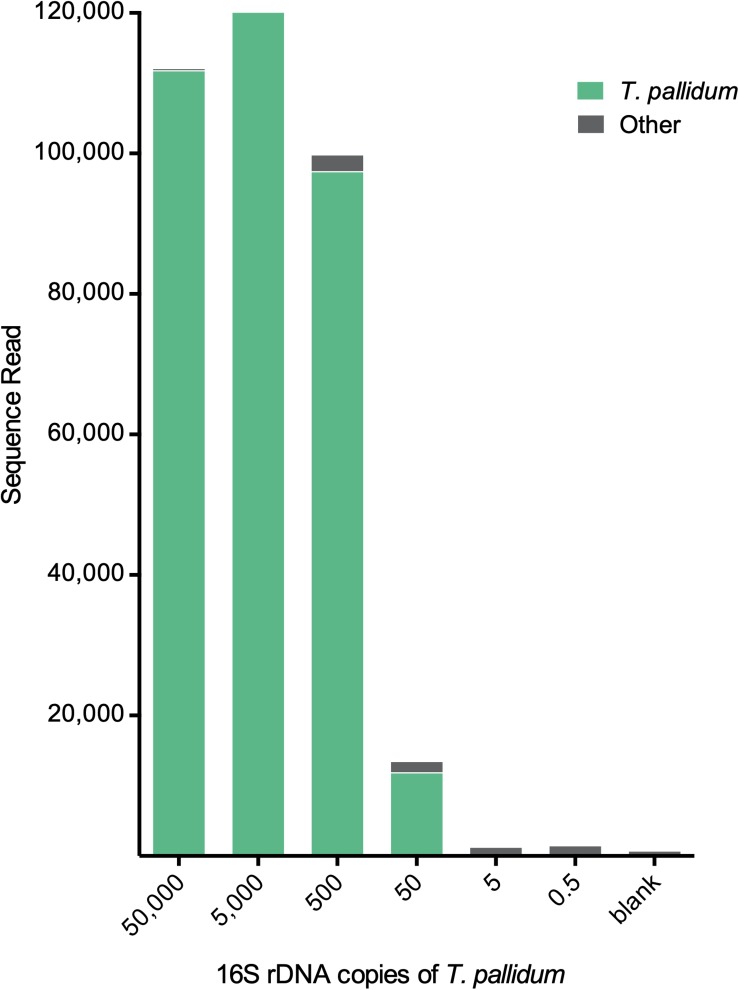
Detection limit of the metagenomic approach for Treponema. Total sequence reads resulting from different input amounts of T. pallidum. Displayed amounts of T. pallidum (50,000–0.5 16S rDNA copies) represent theoretically calculated amounts. Biologically effective range may differ from theoretically calculated amount (e.g., 0.5 copies = 0–2 copies). Blank control represents the 16S rDNA amplification control using microbial DNA-free water as input. For these samples 20 cycles of enrichment PCR was followed by 20 cycles of V4-region-specific PCR (for more detail see the section “Materials and Methods”).